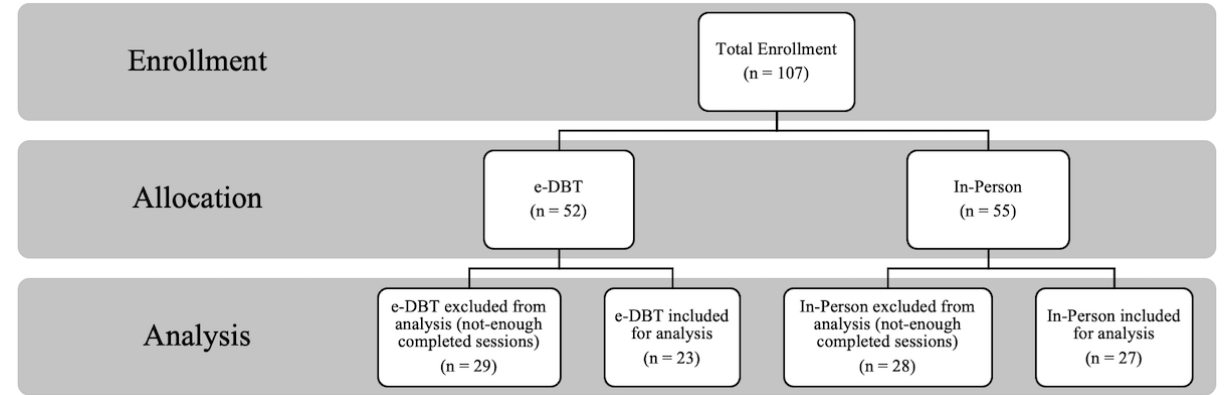
Figure 1. Participant enrollment, allocation, and analysis process. e-DBT: electronically delivered dialectical behavioral therapy.